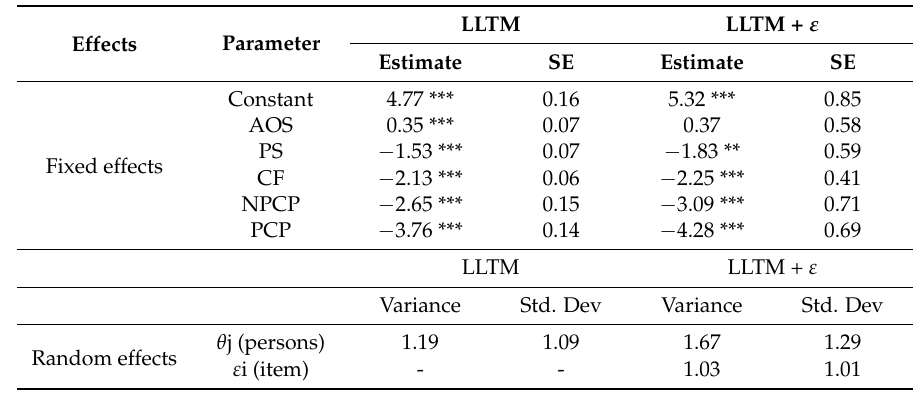
Table 6. Cognitive operator estimates in the linear logistic test model (LLTM) and LLTM + ε predicting item easiness.